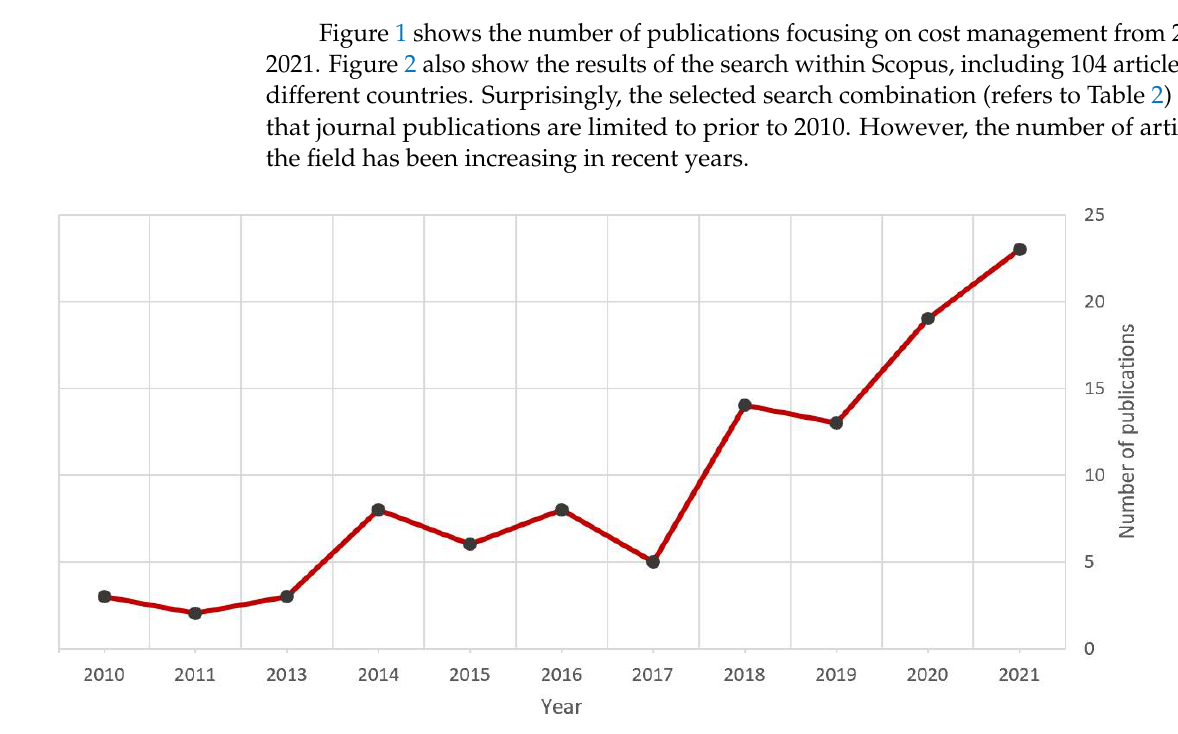
Figure 1. The number of relevant journal articles per year, based on the search results.